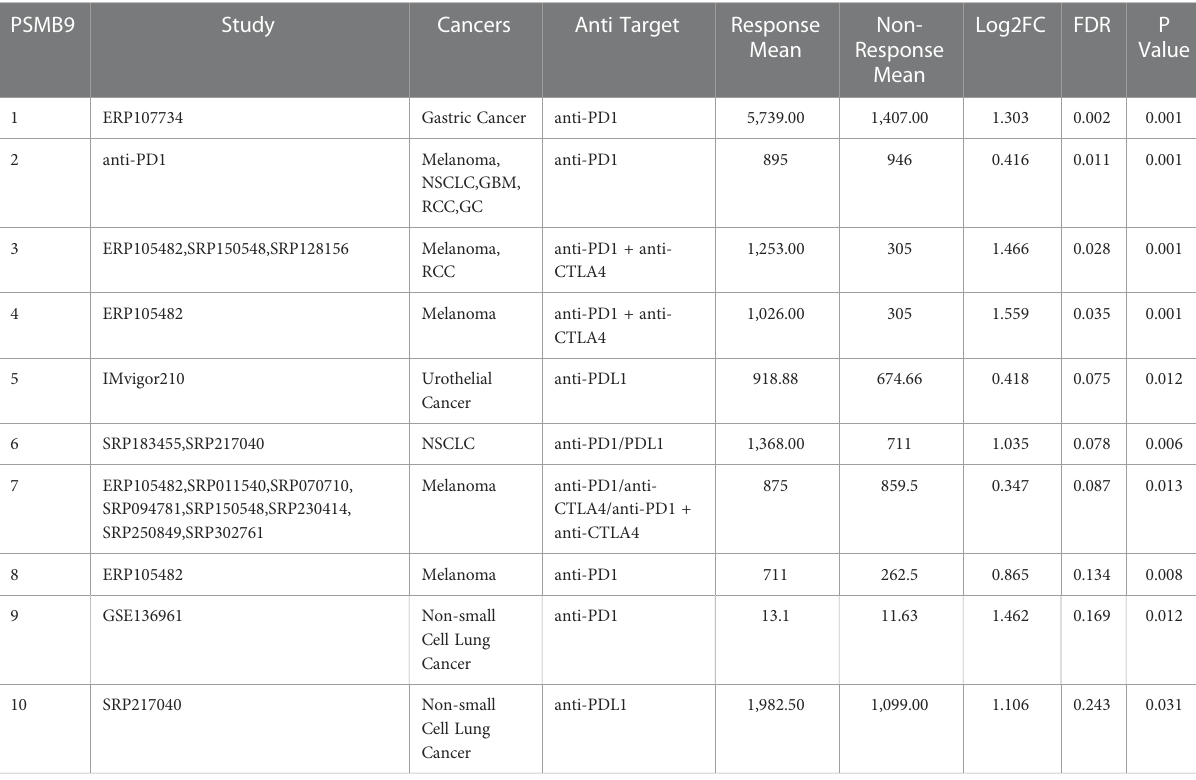
TABLE 2 PSMB9 expression distribution for response and non-response based on pre-treatment samples in all datasets.